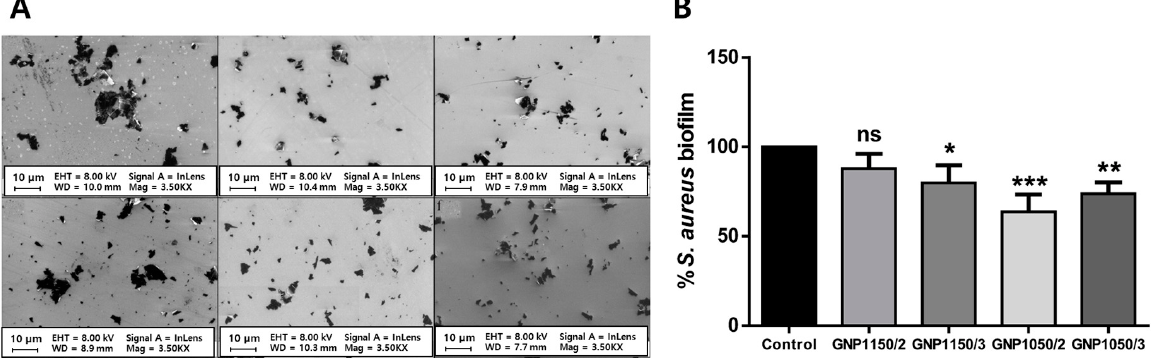
Figure 3. ( A ) Field emission scanning electron microscopy (FE-SEM) on G nanoplatelets fabricated with different conditions. ( B ) Biofilm inhibition for S. aureus . The asterisks denote significant difference compared to control (*: p < 0.05, **: p < 0.01, and ***: p < 0.001). ‘ns’ refers not significant. Data reproduced from Ref. [77]. Copyrights MDPI